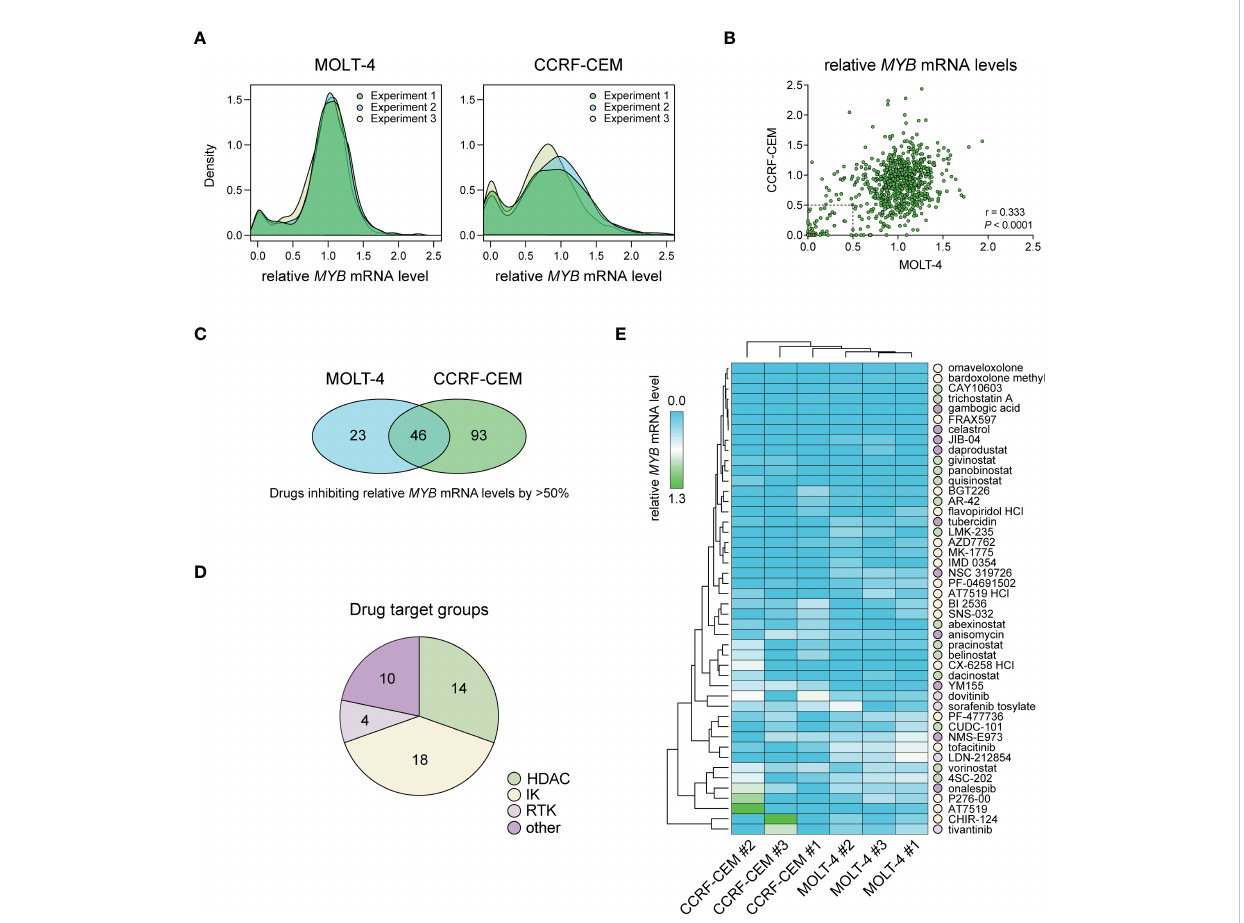
FIGURE 1 Drug screening for inhibitors of MYB gene expression in T-ALL cells with MYB gene activation. (A) Density plots showing treatment effects of 768 small-molecule inhibitors on MYB gene expression in two T-ALL cell lines. Data is derived from three independent experiments. (B) Pearson correlation analysis of treatment response for 768 inhibitors in two T-ALL cell lines. Dashed lines indicate thresholds for 50% MYB mRNA expression compared with DMSO treated control cells. The red dot shows bardoxolone methyl and omaveloxolone that had near identical effects on MYB expression in the screen. (C) Venn diagram showing the number of drugs reducing MYB gene expression with more than 50% in T-ALL cells. (D) Drug target groups of 46 inhibitors reducing MYB mRNA levels with more than 50% in two T-ALL cell lines. (E) Heat map and hierarchical clustering analyses showing the effects of 46 inhibitors on MYB gene expression. Drug targets with grouping as in D are indicated. IK, intracellular kinase; RTK, receptor tyrosine kinase; HDAC, histone